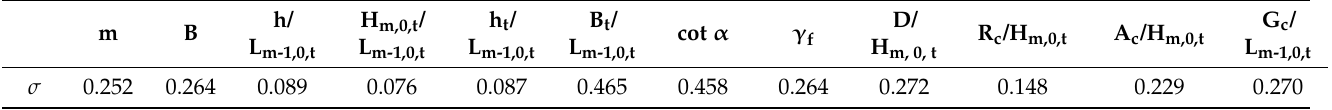
Table 5. Optimal sigma values for each input parameter of the GRNN